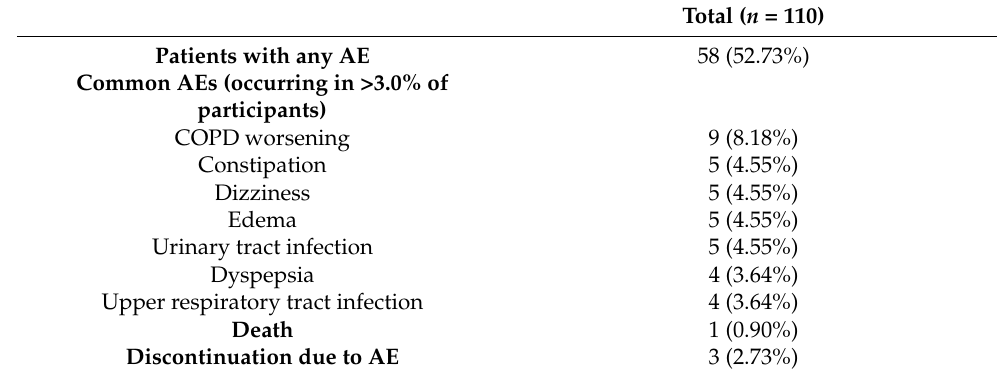
Table 2. Adverse events of the Full Analysis Set.